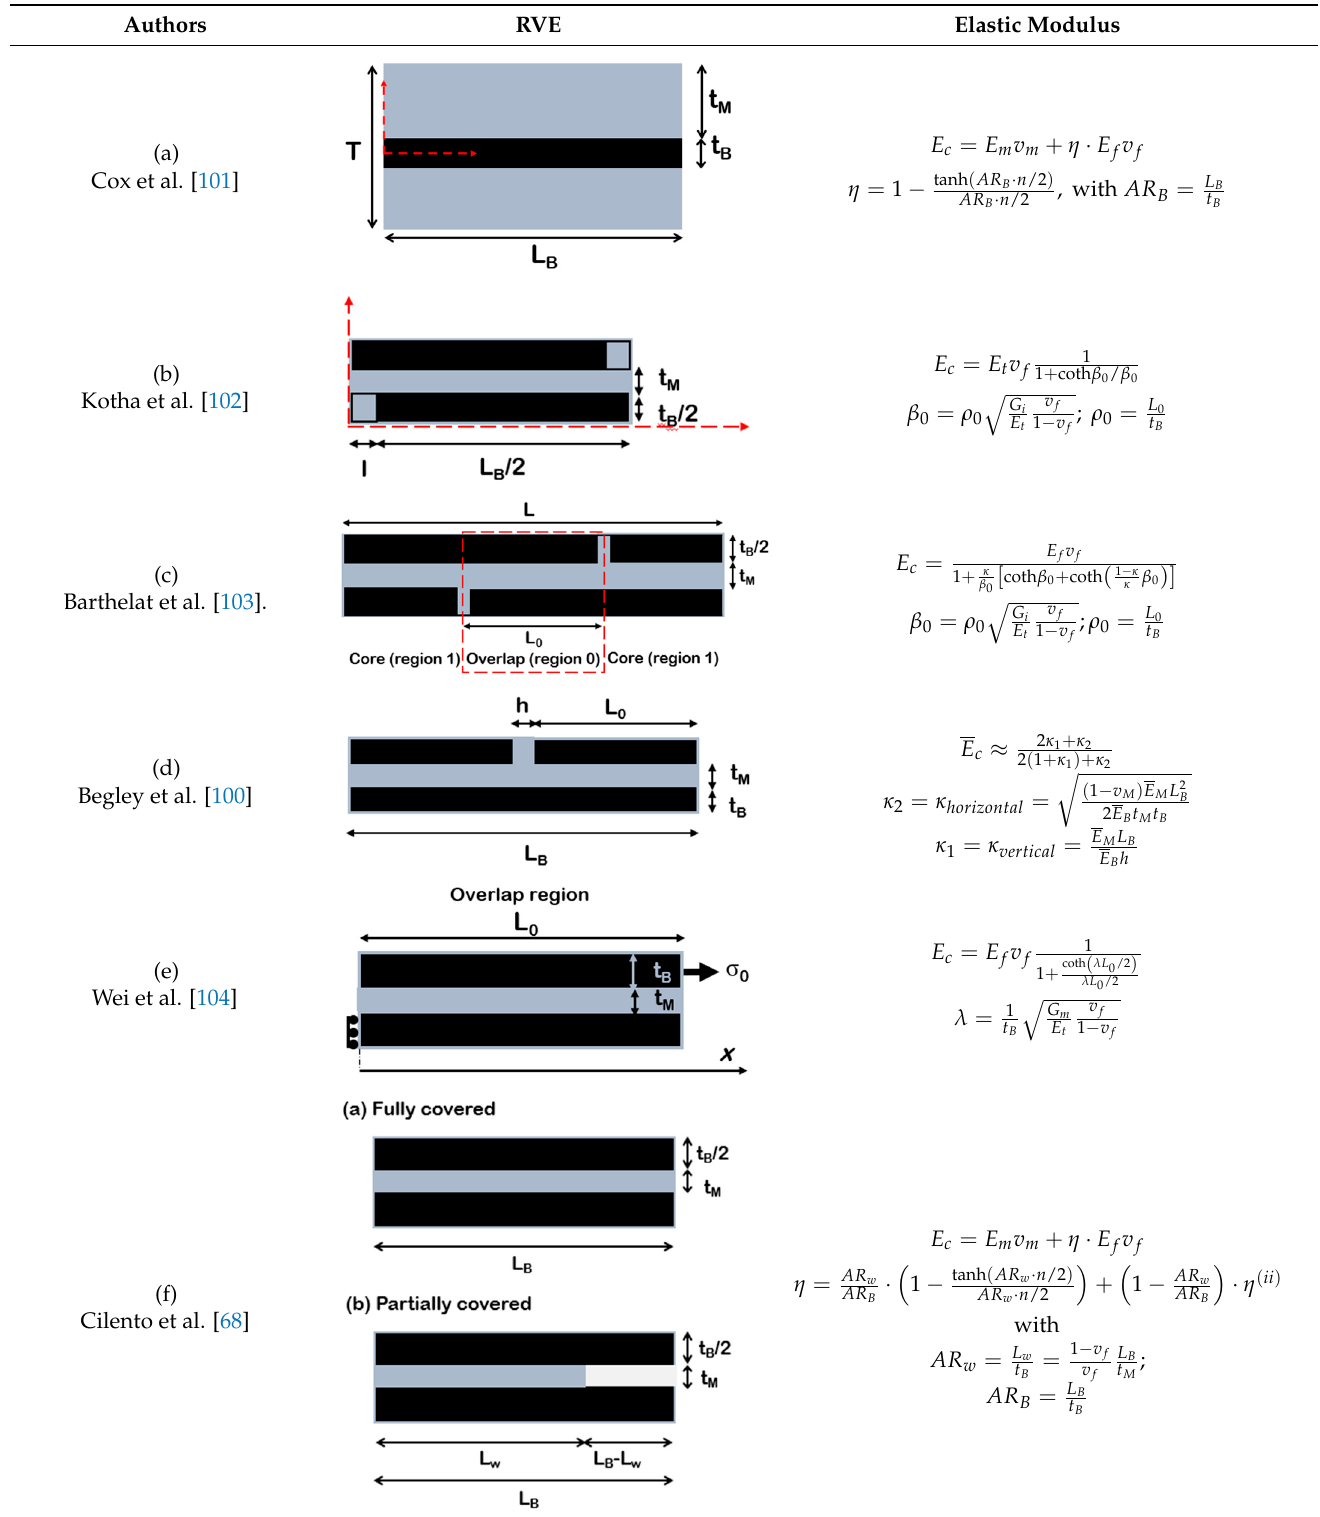
Table 3. Analytical models for the prediction of composite’s elastic modulus.